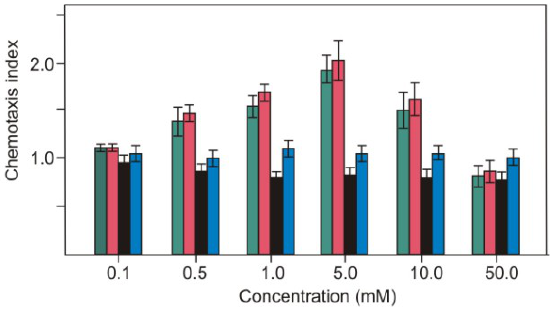
Figure 1. Reaction of vegetative cells of strain CC-124 to nitrite (KNO (KNO ) ( ■ ), KCl ( ■ ) and KH 3